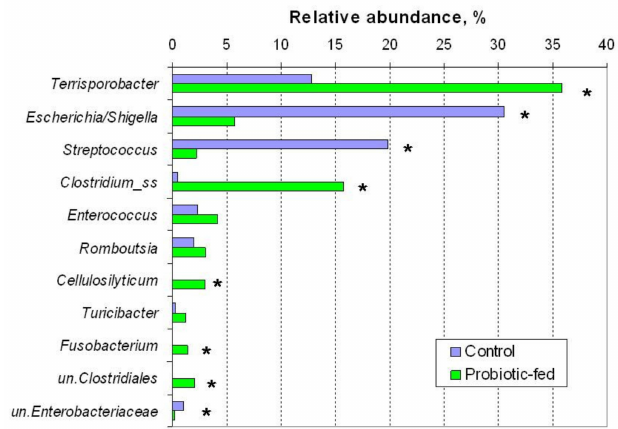
Figure 3. Relative abundance of genera in fecal bacterial assemblages of ducks of the control and probiotic-fed groups. Symbol * at the right of the columns denotes statistically significant difference between the groups (Mann–Whitney test, p ≤ 0.05). “un.” stands for